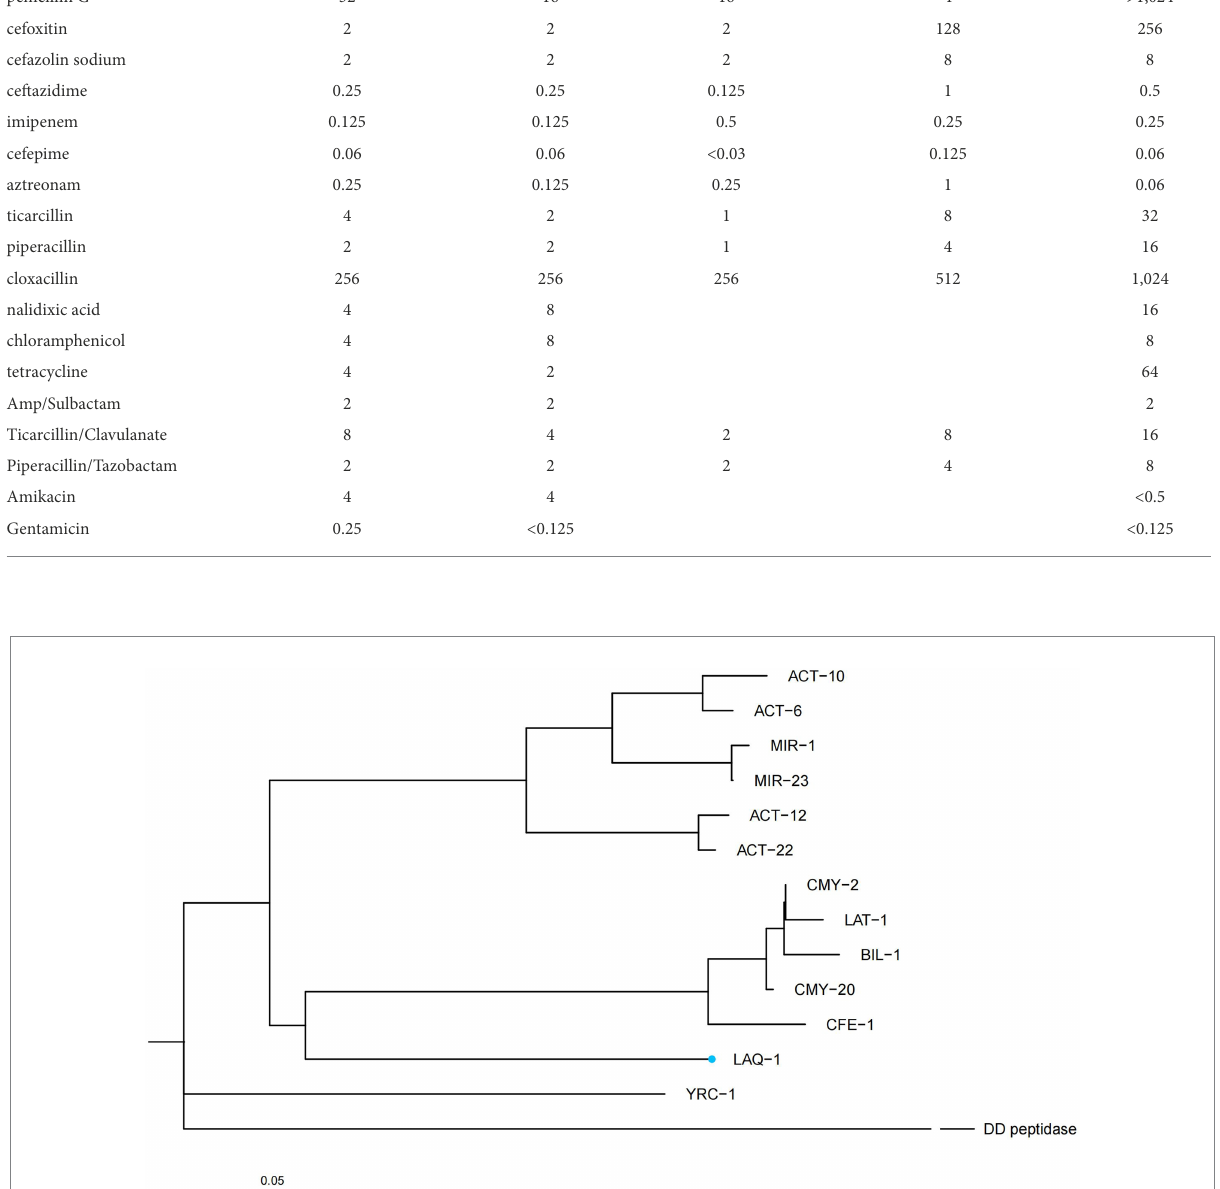
formed a new branch on the phylogenetic tree of AmpC β -lactamases (Figure 2). Comparison of the deduced amino acid sequence of LAQ-1 with the function-characterized β -lactamases revealed that LAQ-1 showed the highest identities of 78.42, 78.42, 77.89, 77.89, 77.63, 77.49 and 77.11% with ACT-6, CMY-20,